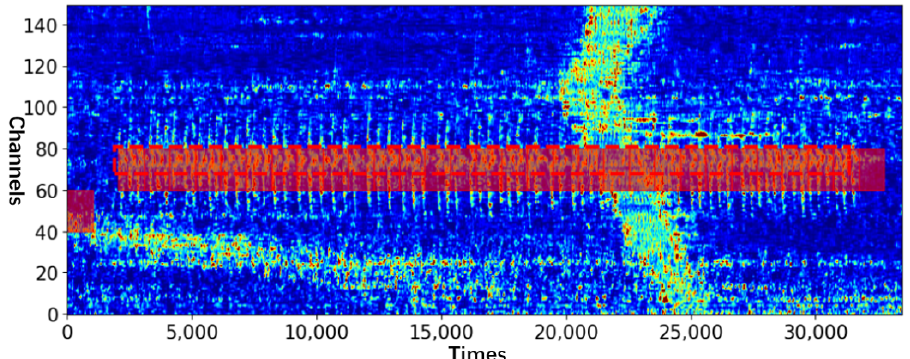
Figure 10. After the accumulation of the model test result window, the red boxes are the detected intrusion windows (scanning period = 1024 and channel width =